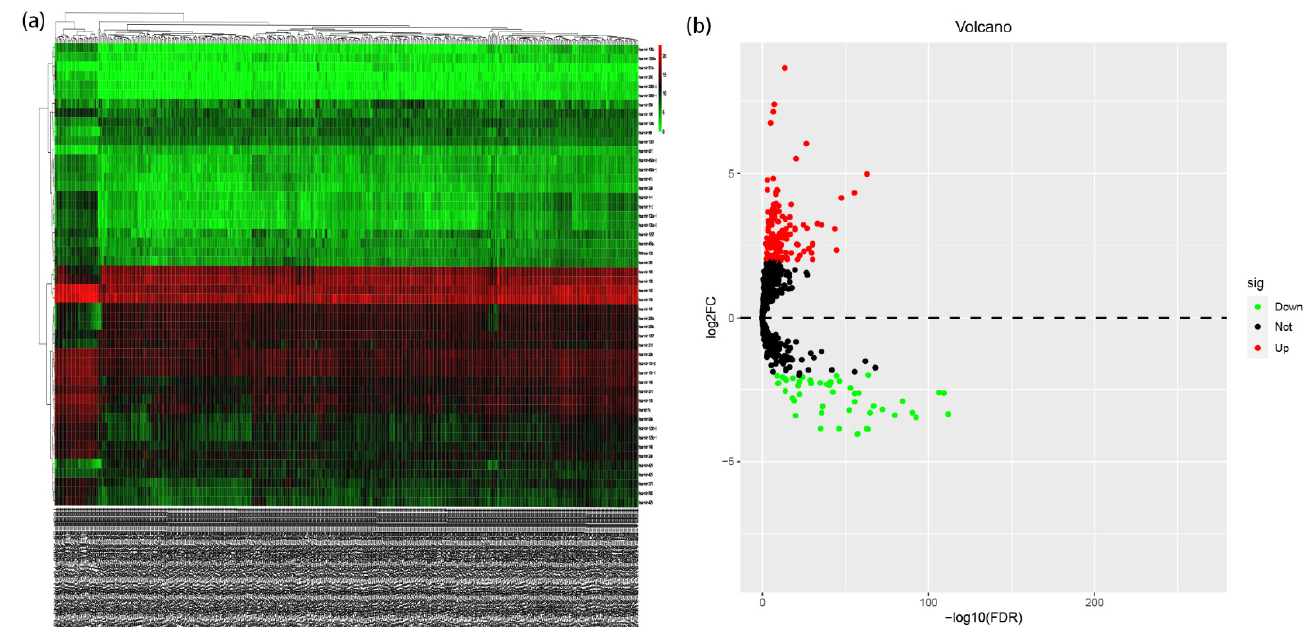
Figure 1. Identification of DEMs associated with EC patients: ( a ) the heatmap of 50 DEMs. Colors represent the expression level of the genes, with darker colors indicating higher expression; red, upregulated; green, downregulated. ( b ) miRNAs vocano plot. A total of 679 miRNAs were identified with the thresholds as |log2foldchange| > 2 and p value < 0.05.